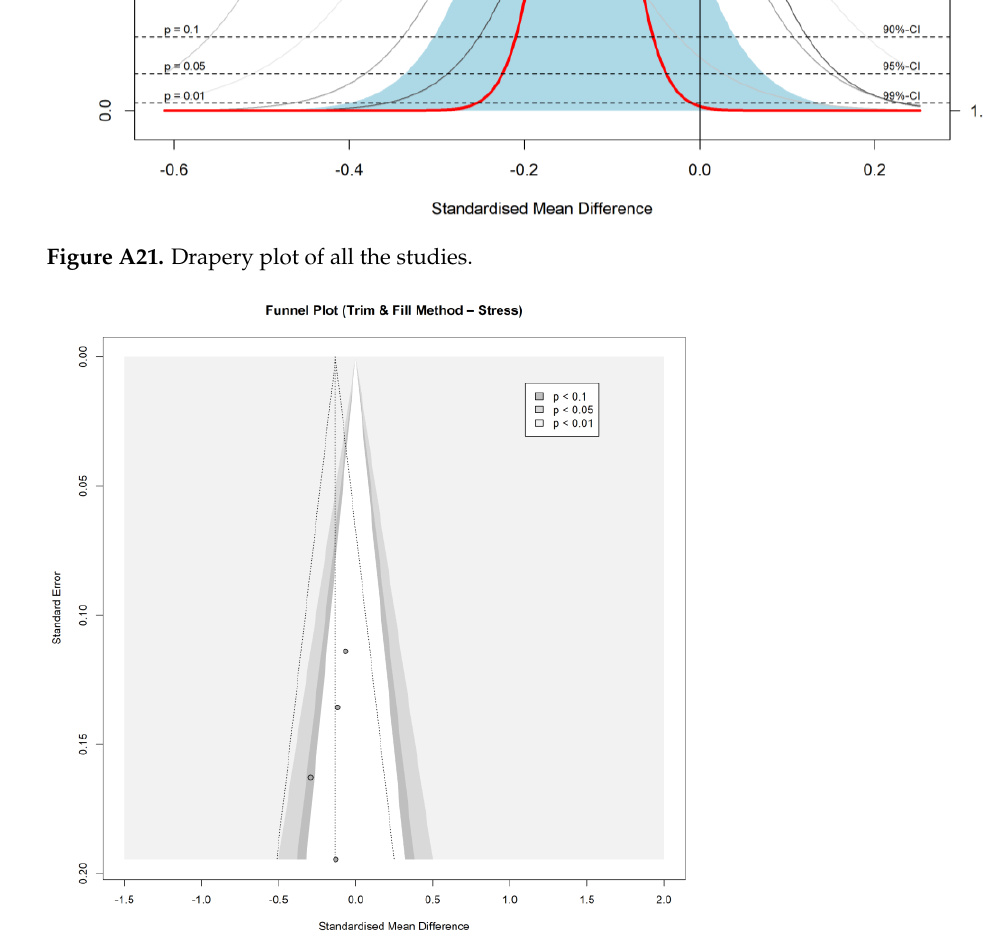
Figure A22. Contour-enhanced funnel plot of the studies included in the sensitivity analysis and the studies filled to adjust for publication bias. The trim and fill method did not add any study.